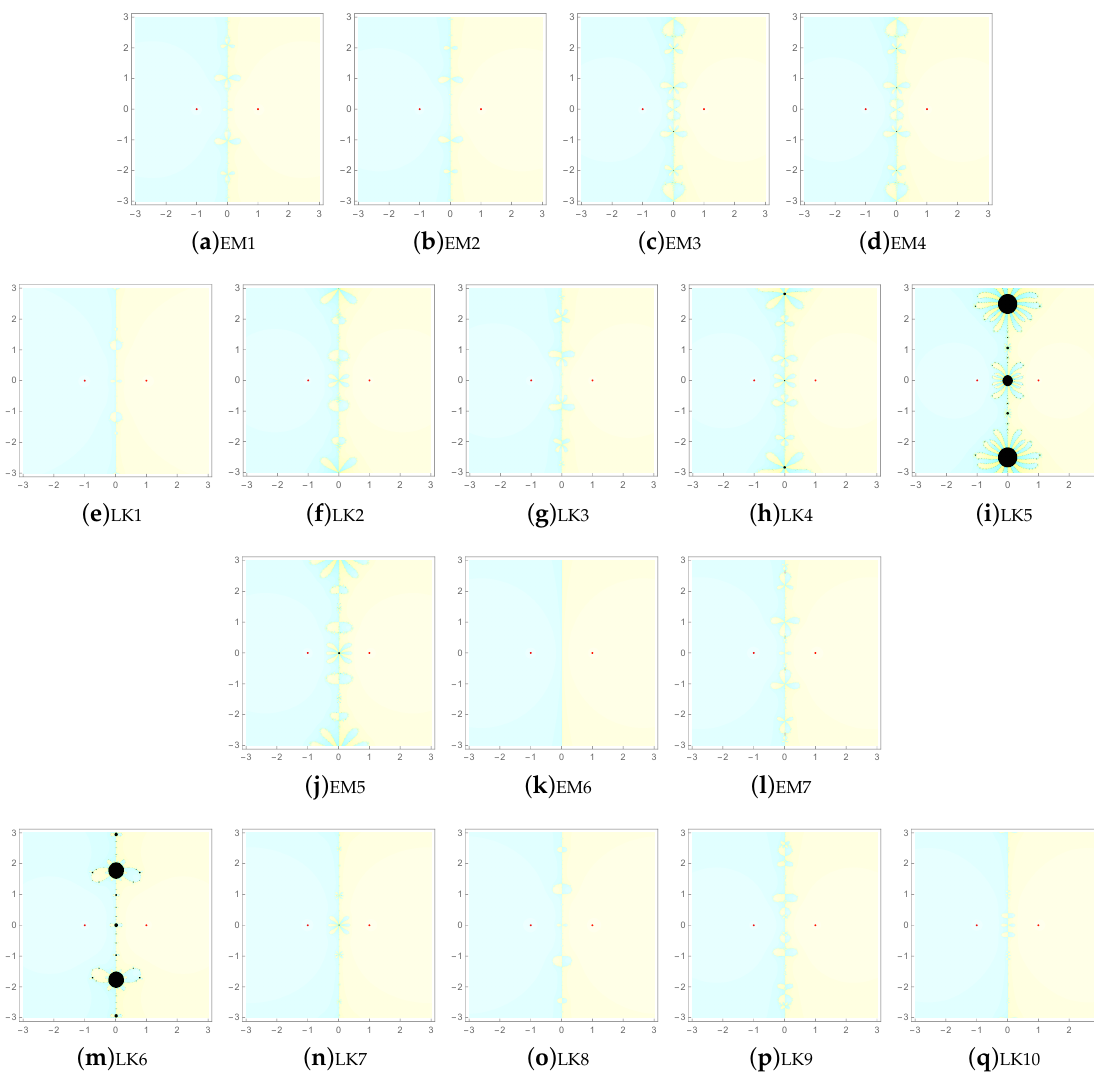
Figure 1. Basins of attraction of the listed methods, for the roots of the polynomial z 2 −